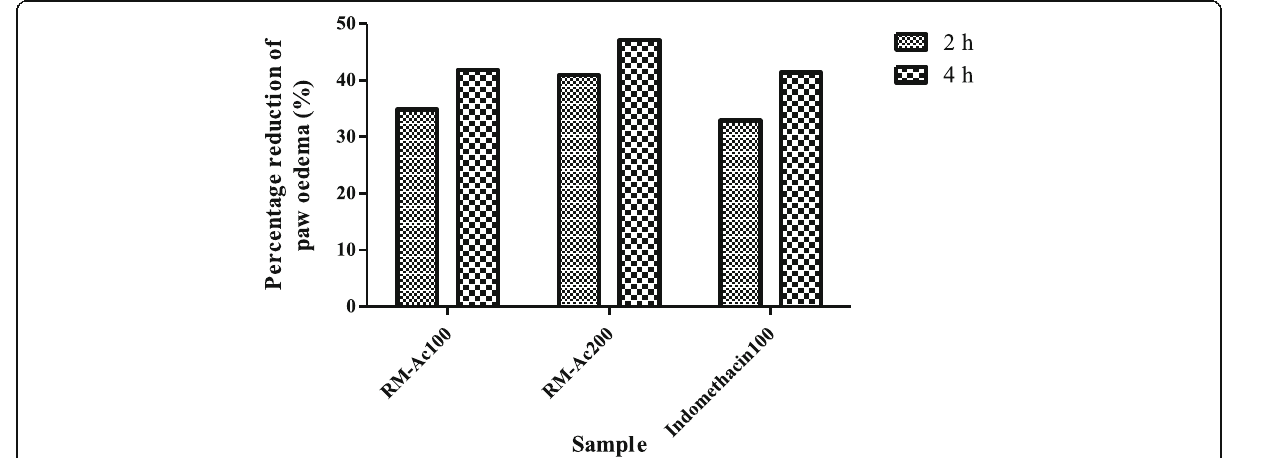
cancer cells and NHME cell lines, by using SRB assay, and the % cell growth inhibition was represented in Additional file 1: Table S4. Samples that are active against cancer cell lines were further screened at different concentrations for RM-Ac (25, 50, 75 and 100 μ g/mL), compounds 1 – 9 (5, 10, 20 and 30 μ g/mL) and doxorubicin (2.5, 5.0, 7.5 and 10 μ g/mL). The outcomes of percentage cell growth inhibition against concentrations are plotted to attain IC values. The poorer IC value directs 50 50 improved inhibitory activity against cancer cells.